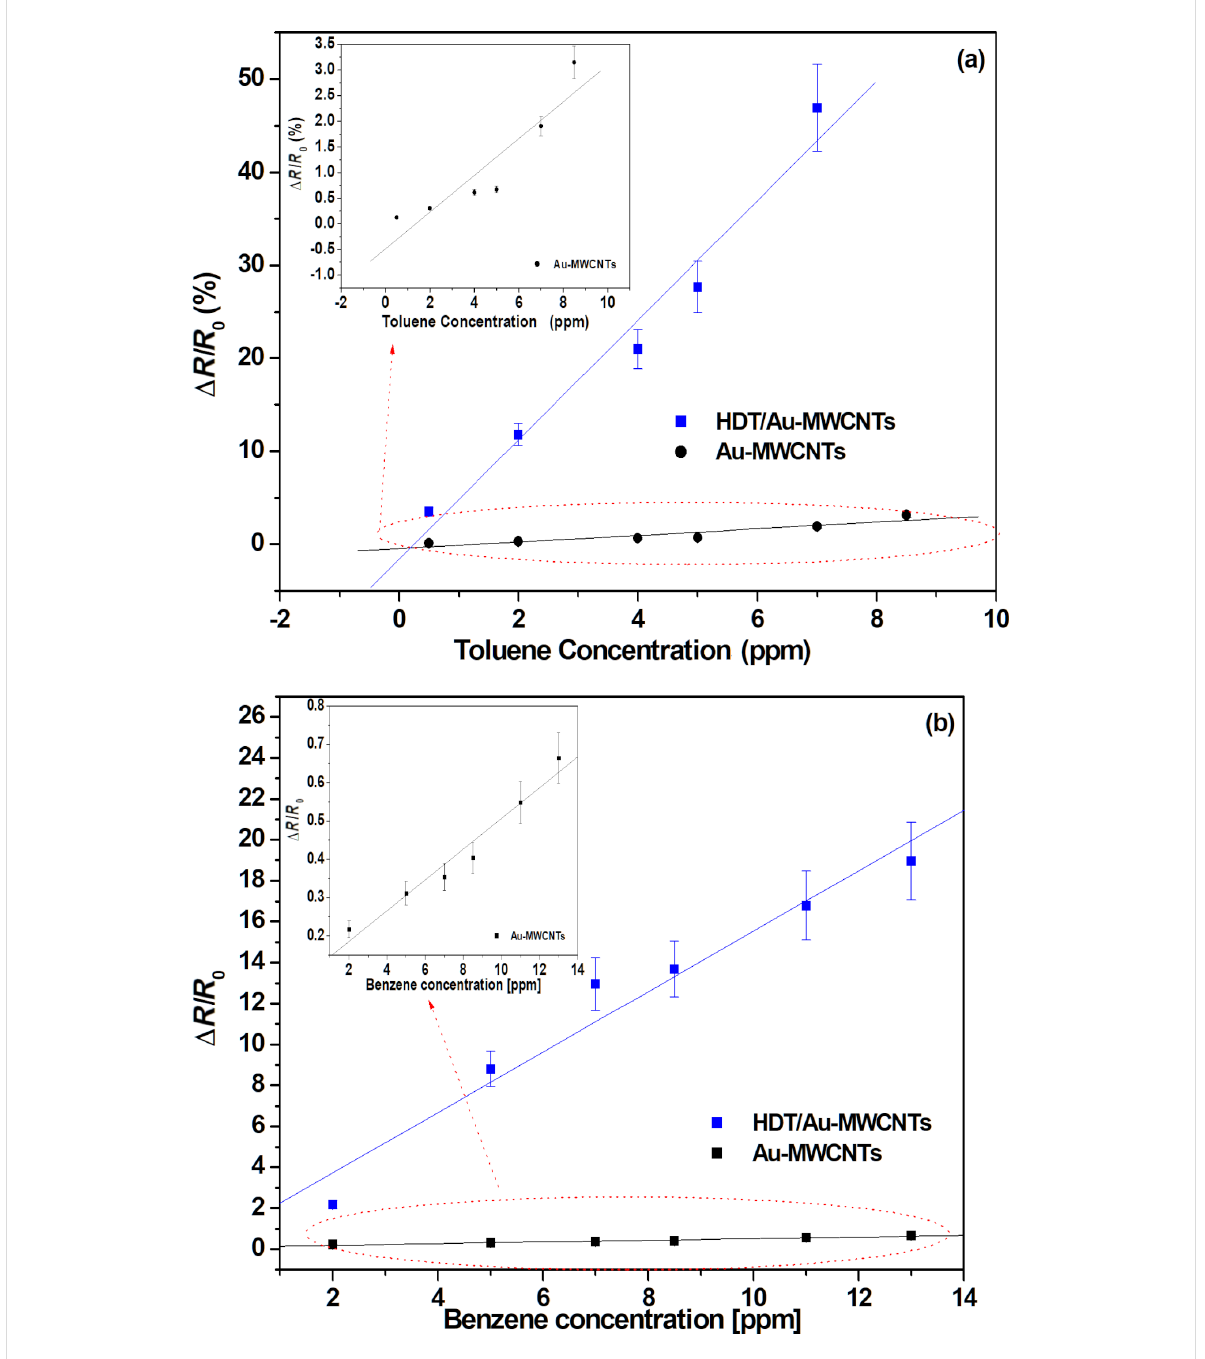
Figure 6: Calibration curves for Au-MWCNT and HDT/Au-MWCNT sensors for (a) toluene and (b) benzene aromatic VOC detection.